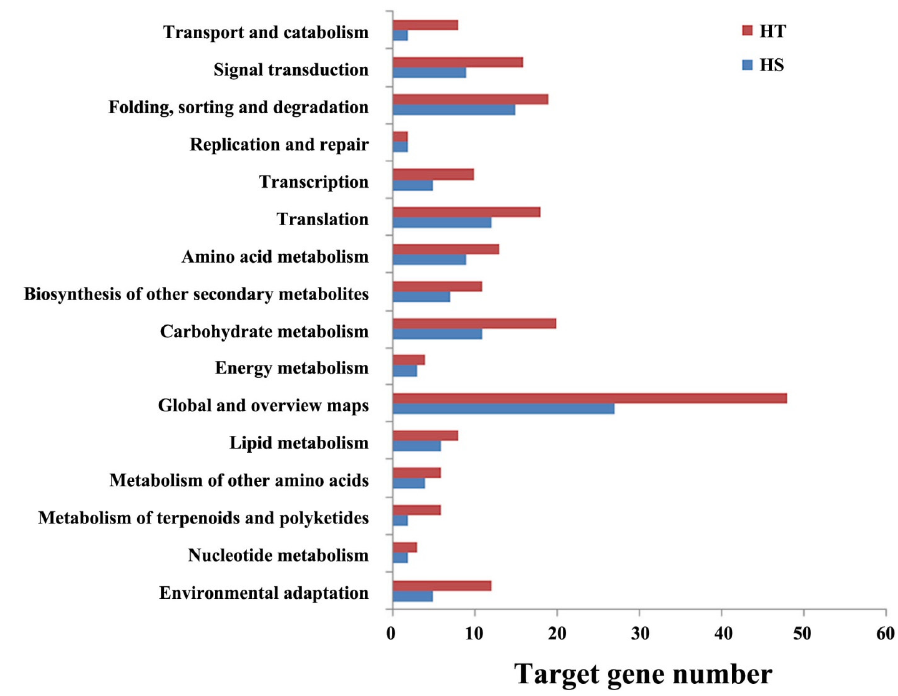
Figure 5. KEGG pathway analysis of target genes of heat responsive microRNAs in the heat-tolerant (HT) and heat-sensitive (HS) genotypes of flowering Chinese cabbage.